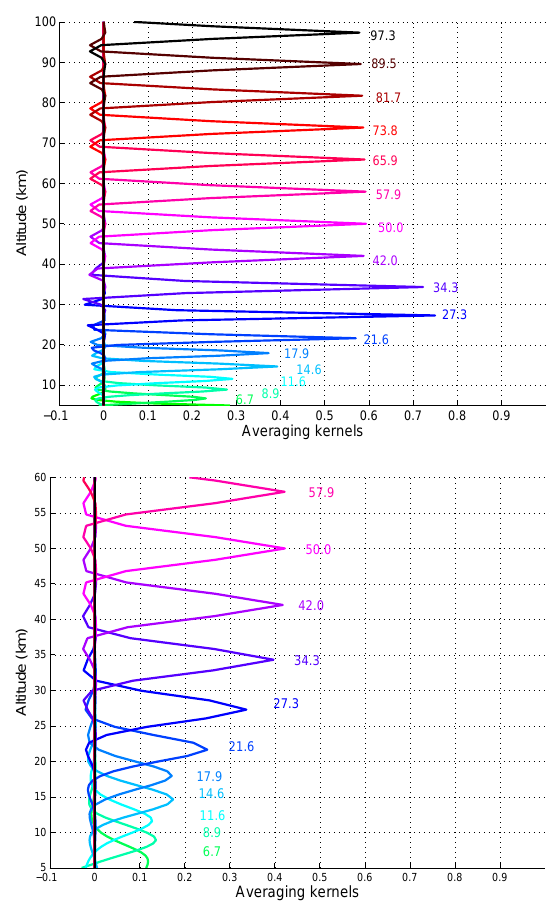
Fig. 11. Examples of averaging kernels. Top panel: O 3 , bottom panel: NO 2 . The averaging kernnels of NO 3 and aerosols are equal with the averaging kernels of NO 2 . The averaging kernels peak at the altitude they corresond (given in the figure in km). Note that only every 5th averaging kernel is